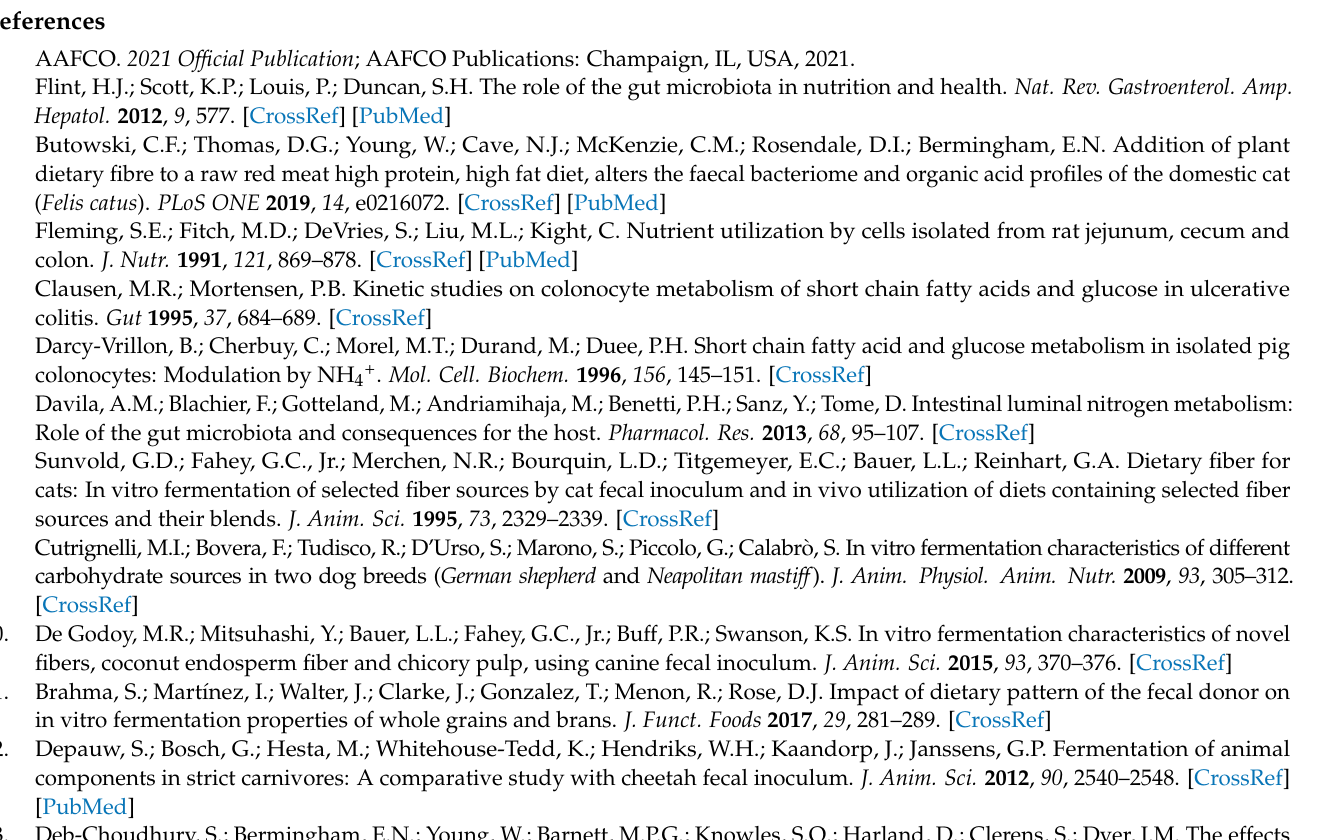
Figure A3. Assessment of alpha diversity using the Chao1 diversity index from samples following in vitro fermentation of substrates at the 24-h time point using high carbohydrate faecal inoculum (CD). Small circles denote outliers.